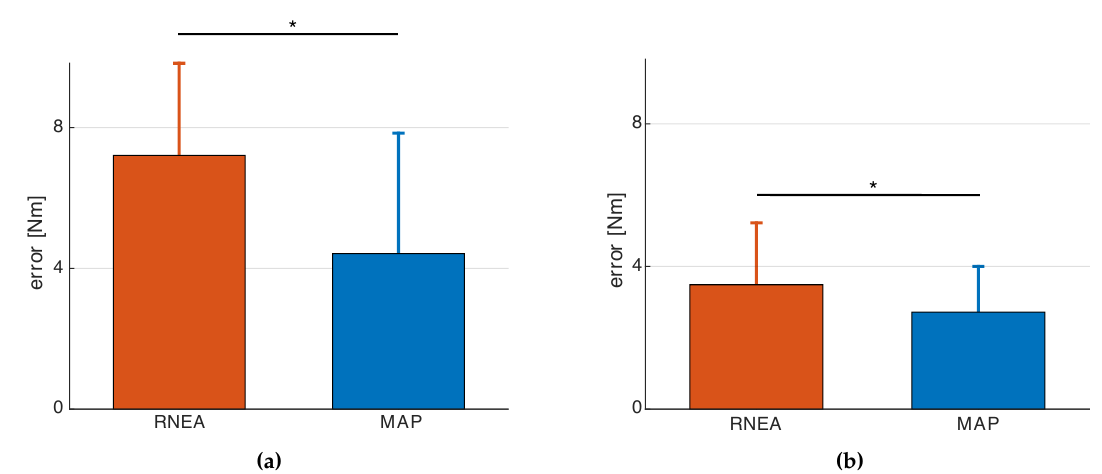
Figure 8. Error on torque estimation comparing RNEA and MAP methods on τ 1 ( a ) and τ 2 ( b ), (* p -value <